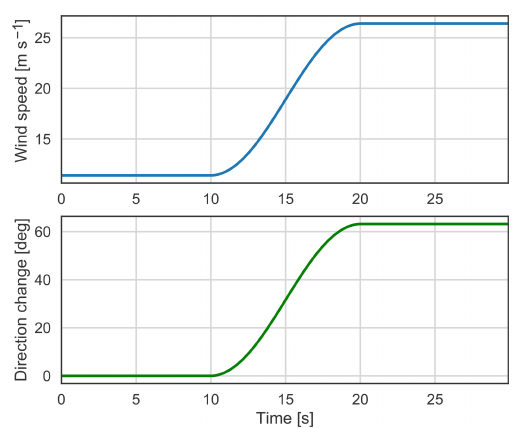
Figure 6. The extreme coherent gust with direction change from the IEC wind turbine safety standard.